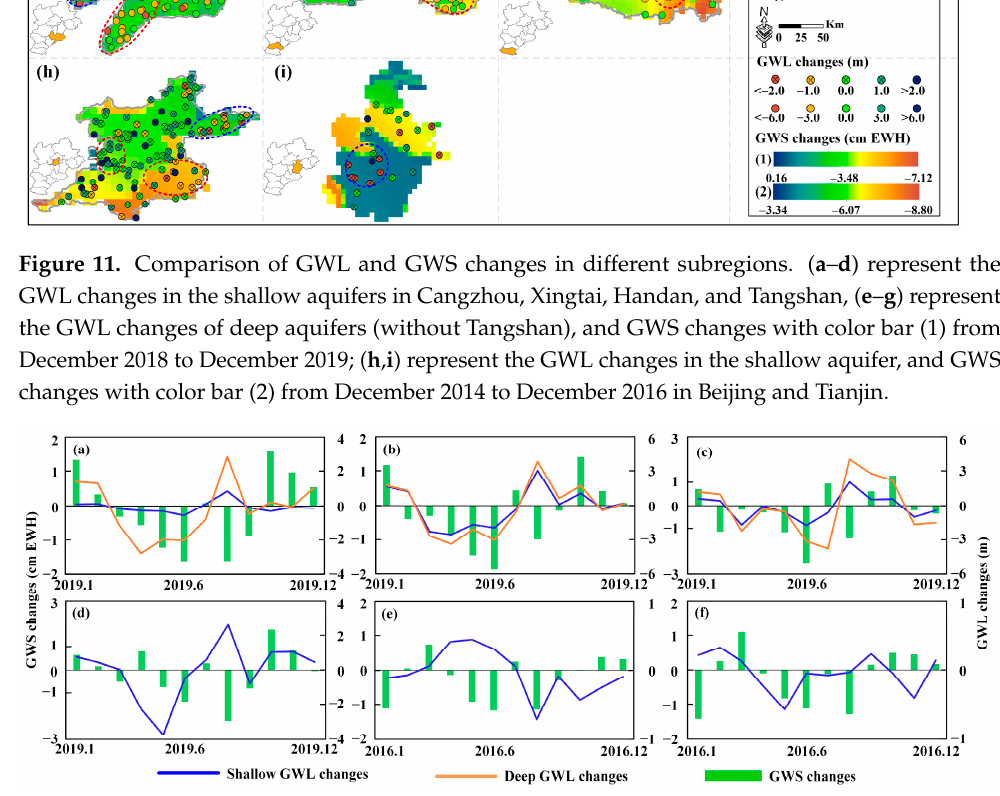
Figure 11. Comparison of GWL and GWS changes in different subregions. ( a – d ) represent the GWL changes in the shallow aquifers in Cangzhou, Xingtai, Handan, and Tangshan, ( e – g ) represent the GWL changes of deep aquifers (without Tangshan), and GWS changes with color bar (1) from De- cember 2018 to December 2019; ( h , i ) represent the GWL changes in the shallow aquifer, and GWS changes with color bar (2) from December 2014 to December 2016 in Beijing and Tianjin.